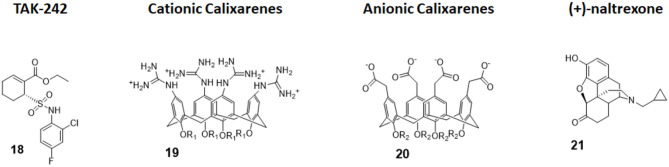
Non-glycolipidic TLR4 antagonists. TAK-242 is a potent TLR4 inhibitor non-competitive toward LPS. Cationic Calixarenes, were able to block TLR4 signaling while anionic calixarenes were inactive. (+)-N17-subsituted Naltrexone derivatives are the only known TLR4 antagonists able to cross the BBB to date and are drug candidate for neuropathic pain.